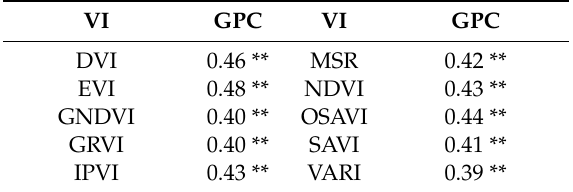
Table 4. Correlation between VI and grain protein content (GPC) (n = 109).